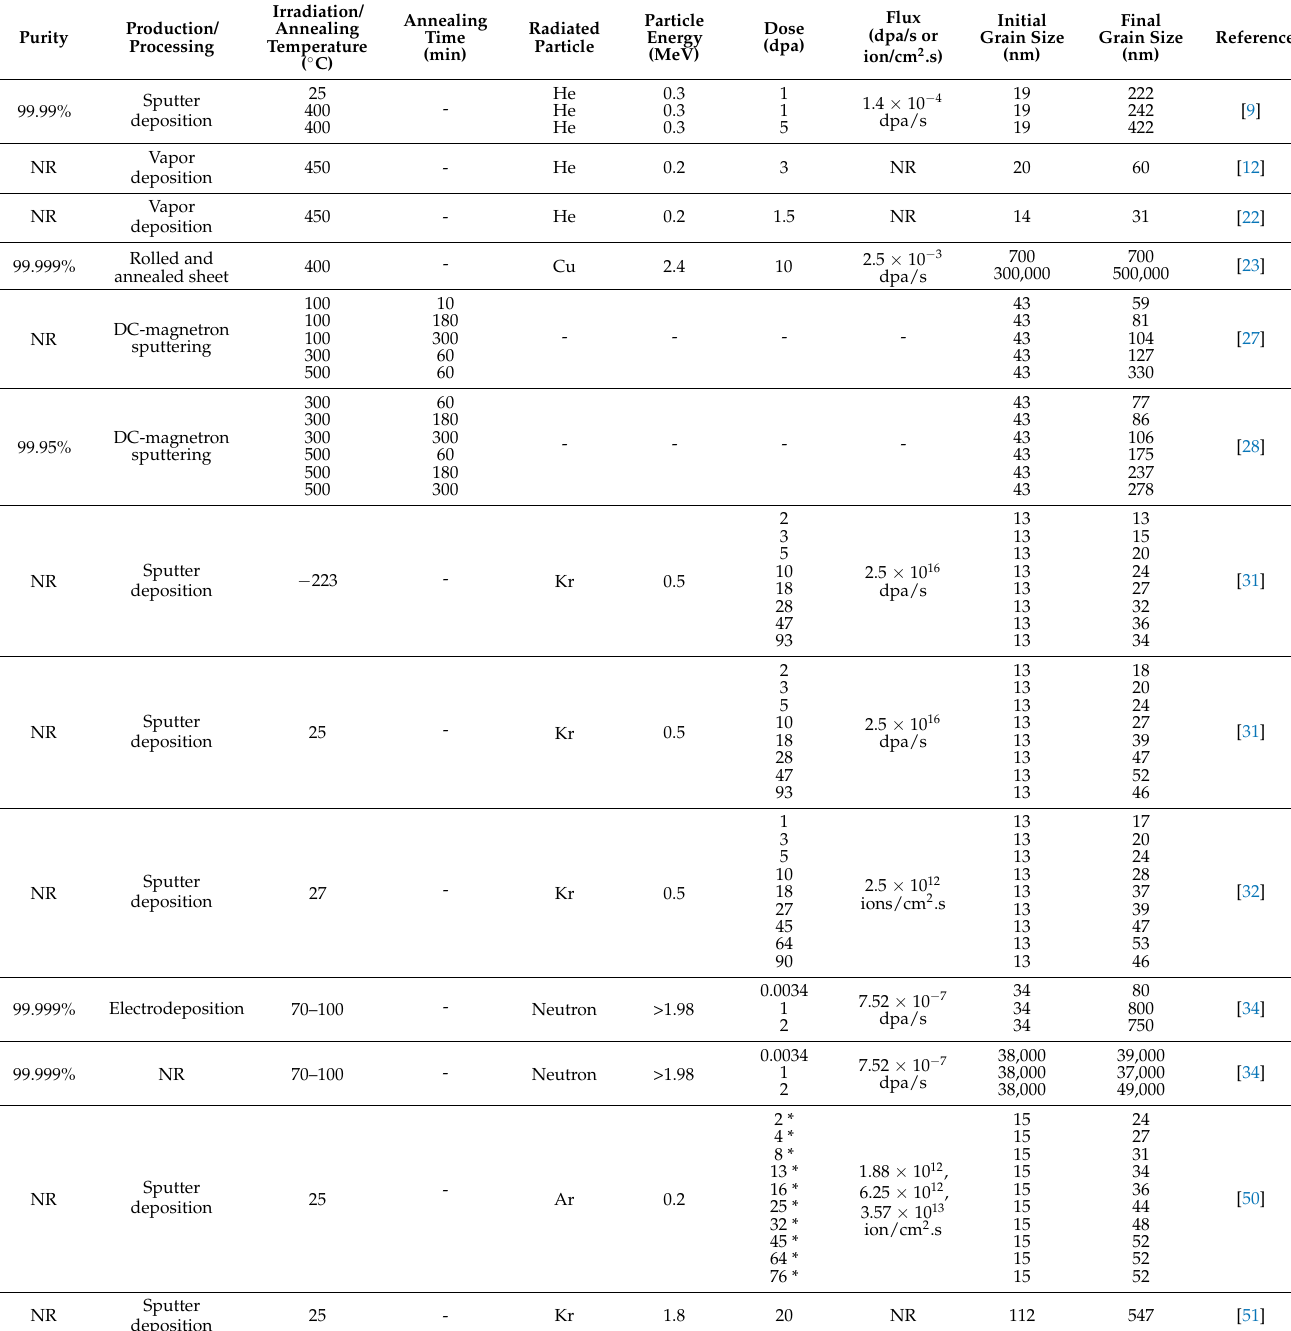
Table 1. Select published results for irradiation-induced grain growth for pure